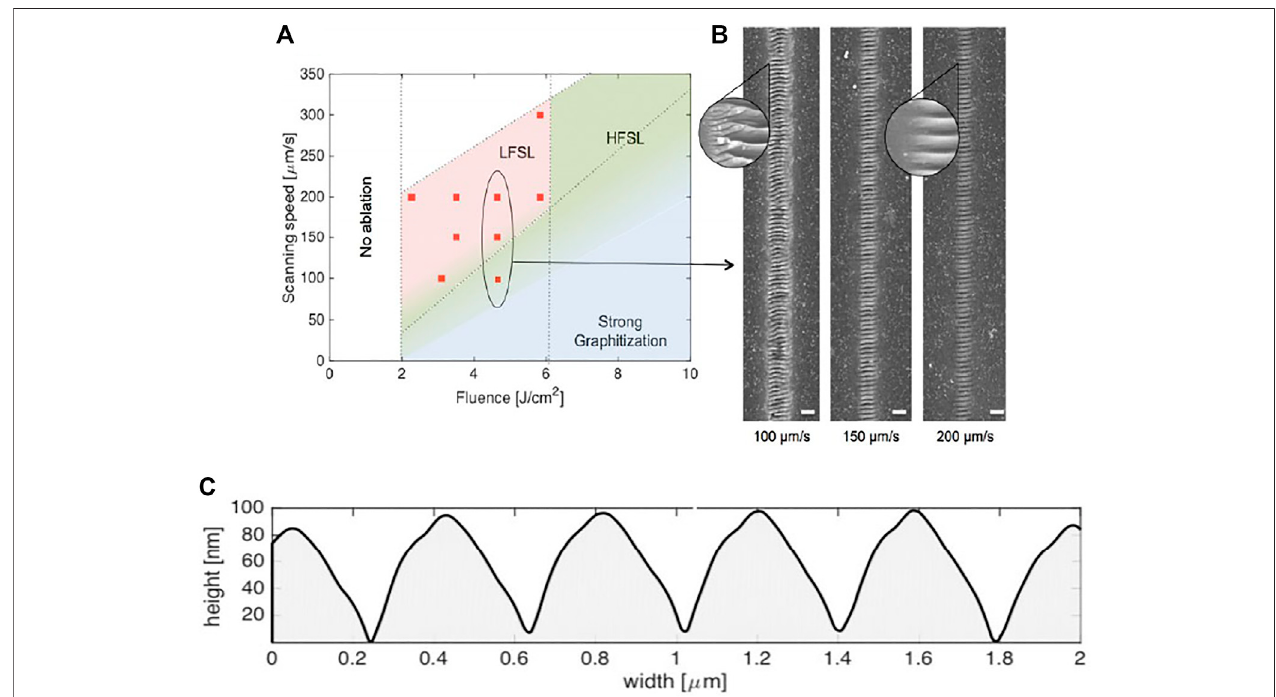
FIGURE3|(A) Formationofdiamondstructuresdependingonlaser fl uenceandscanningspeed. (B) Morphologyofthenano-ripplesfordifferentscanningspeeds at a fi xed fl uence. Scale bar (cid:2) 1 μ m. (C) Line-out of the surface structures [27].